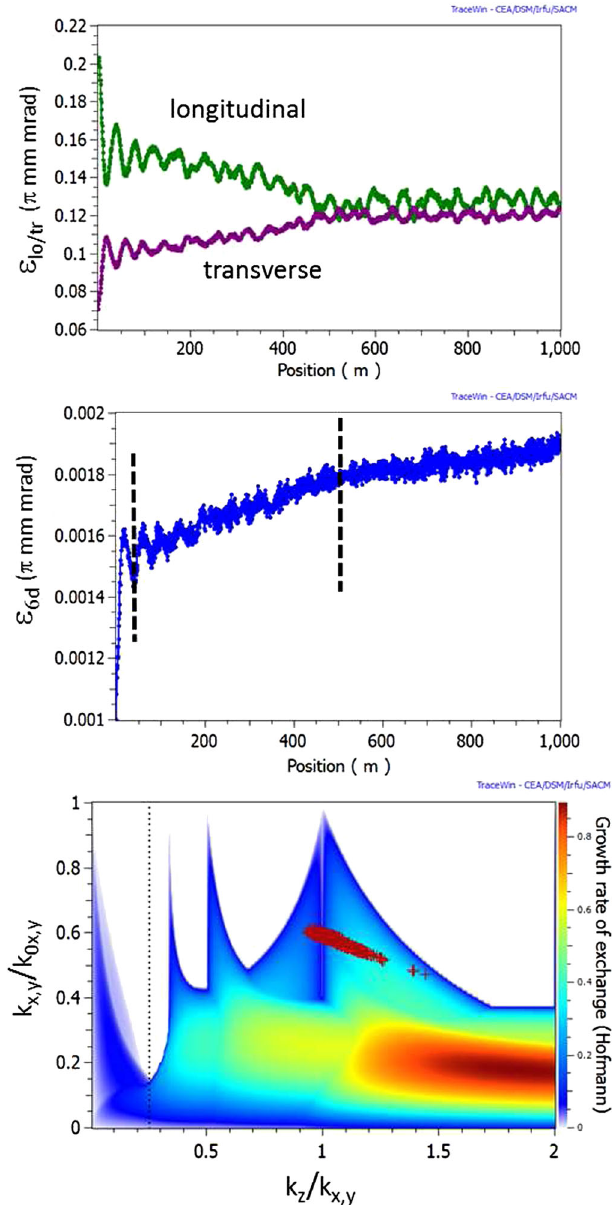
FIG. 2. Rms emittances (top); ϵ 6 d (center, with dashed lines indicating transitions between different regimes); and stability chart (bottom; color scale indicating theoretical rates of emittance change) for ϵ z = ϵ xy ¼ 3 including tune footprint over 1000 periodic cells